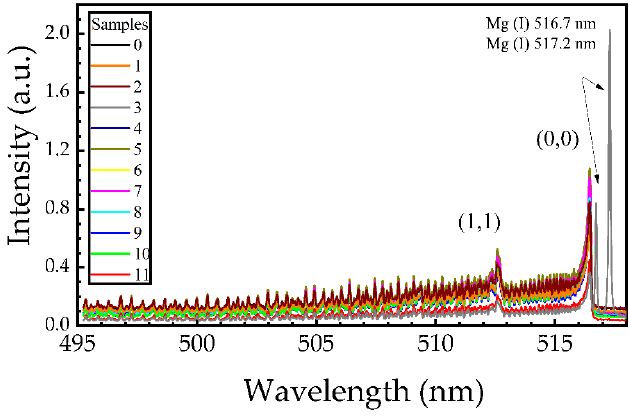
Figure 4. C 2 Swan band ( ∆ v = 0) spectra of the polymers.